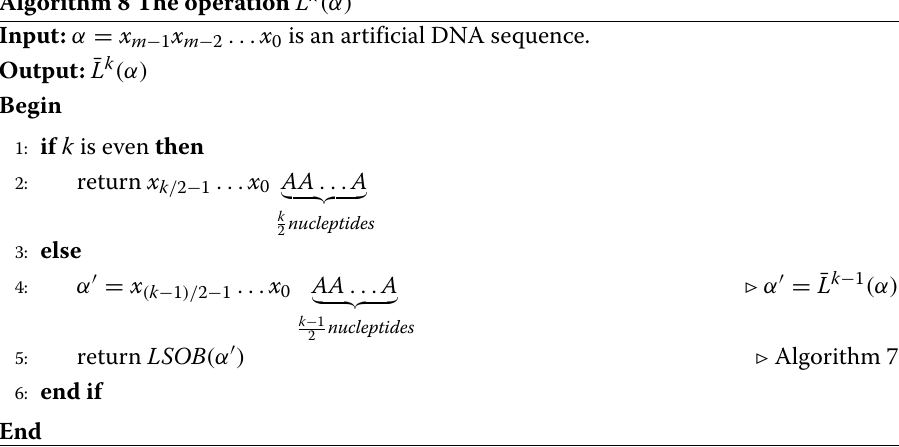
Algorithm 8 The operation